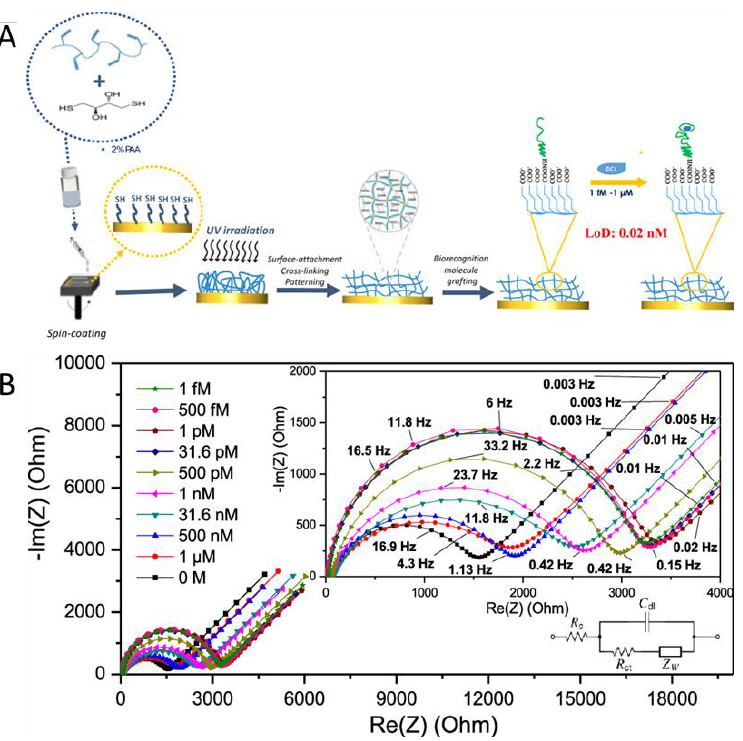
Figure 9. ( A ) Schematic representation of hydrogel preparation and sensing mechanism of DC. ( B ) Nyquist plot obtained in 0.1 M PBS containing 5 mM K 4 [Fe(CN) 6 ] and K 3 [Fe(CN) 6 ] after treatment of the aptasensor with different concentrations of DCL in the frequency range of 100 kHz to 1 mHz (Reprinted with permission from [106]. Copyright 2020 American Chemical Society).